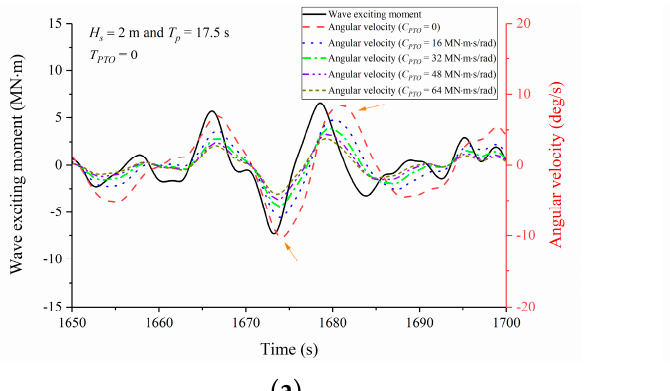
Figure 27. Time–history wave exciting moment and angular velocities under a modified irregular wave ( H s = 2 m and T p = 17.5 s in 12.5 m-deep water) during five repetitions of the peak period: